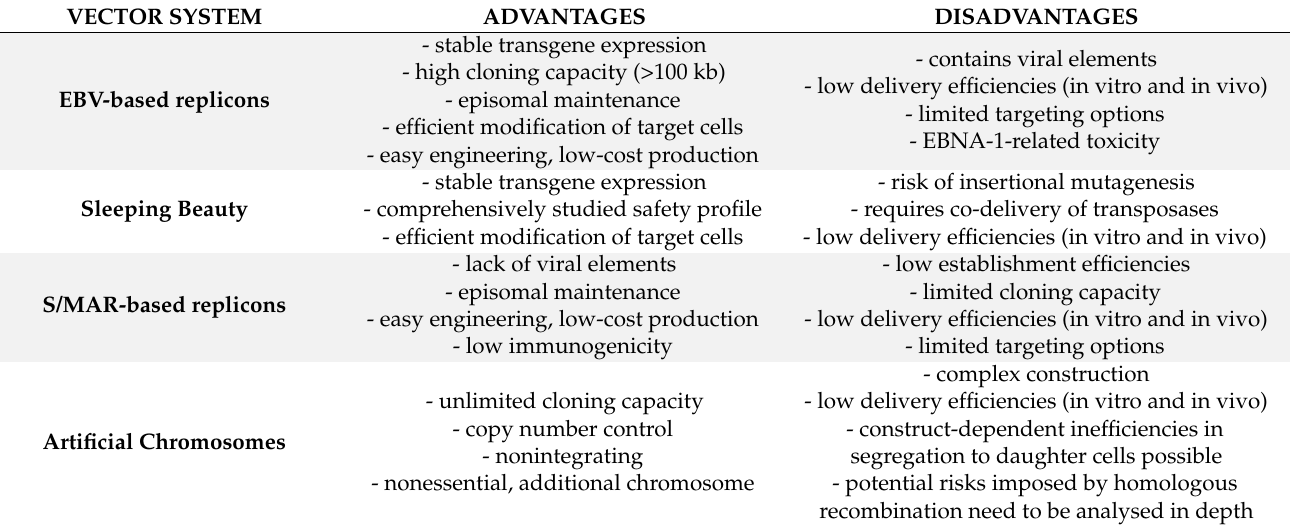
Table 1. Advantages and disadvantages of nonviral vector systems. The major limitation of each vector system is marked in bold. The term delivery efficiency, as used here, refers to the ratio of the copy number of genetic material that becomes established/integrated into target cells to the copy number of genetic material used for initial